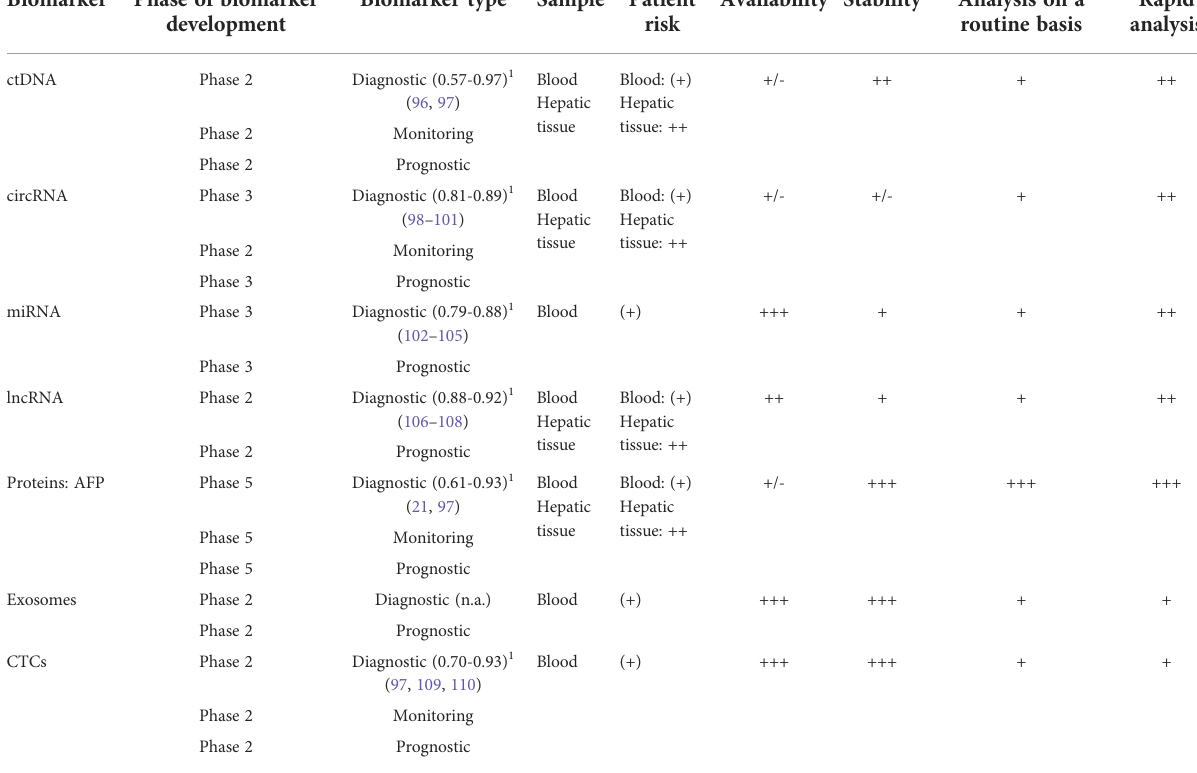
TABLE 1 Overview of relevant biomarker classes for